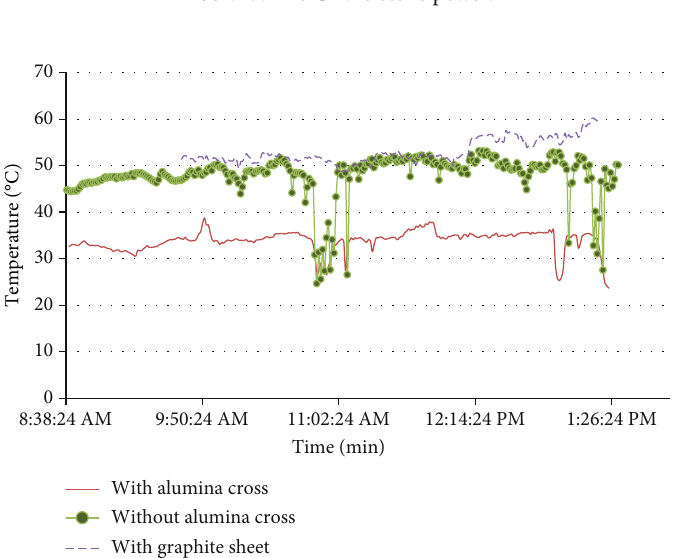
Figure 7: The CPV electric power.